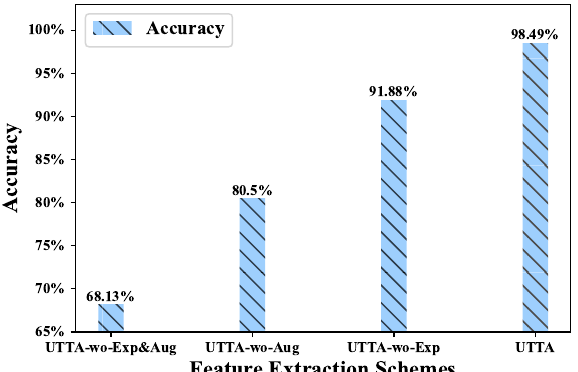
Figure 9. Impact study of data expansion and data augmentation.